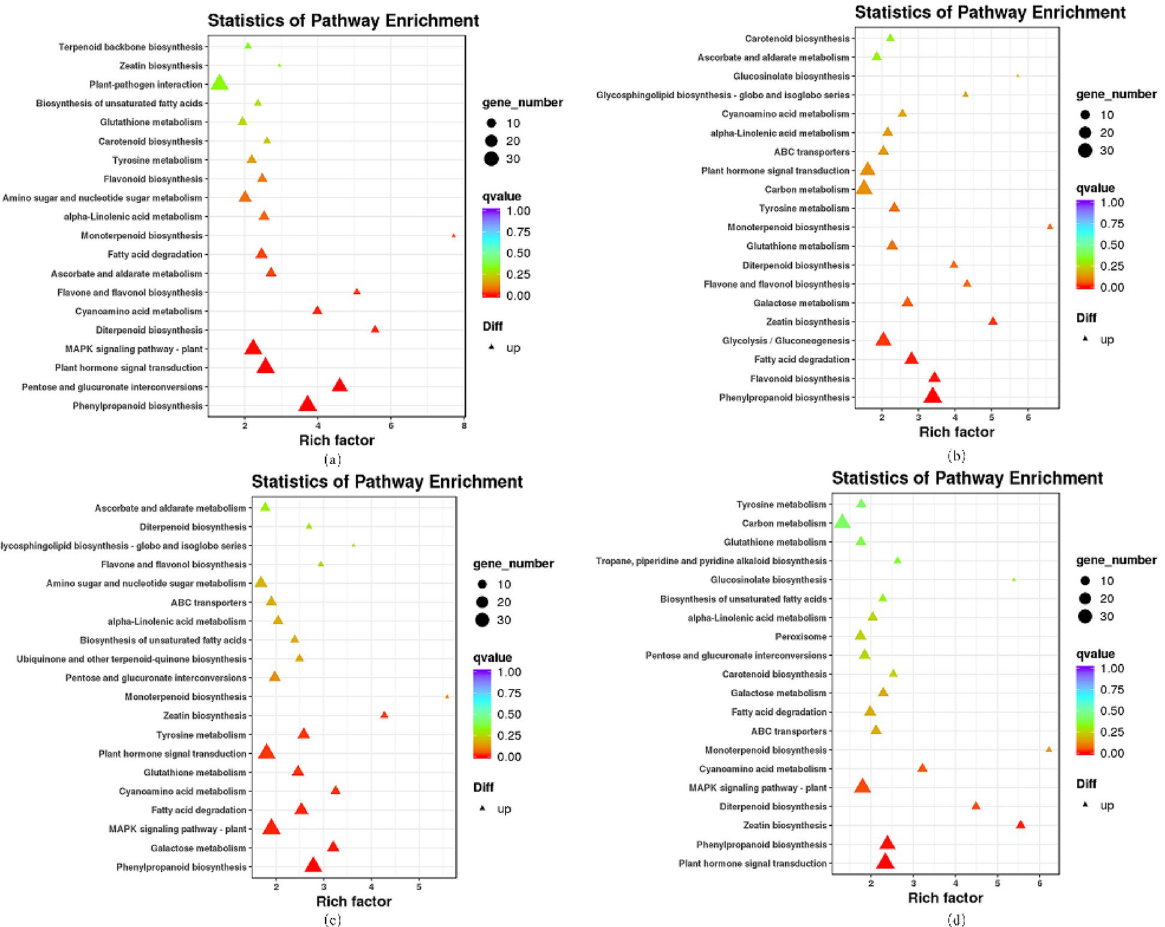
Figure 4. Statistics of KEGG enrichment for DEGs. ( a ) s0 vs. s1; ( b ) s0 vs. s2; ( c ) s0 vs. s3; ( d ) s0 vs. s4; Each circle in the figure represents a KEGG pathway, the Y-axis represents the pathway name, and the X-axis represents number of transcripts (circle size) enriched in the pathway, while the color code represents q-value and the size represents the gene